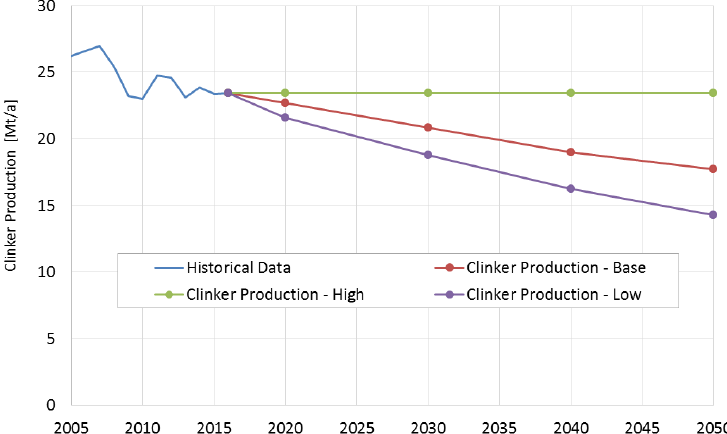
Figure 7. German clinker production projections, base, and low scenarios taken from Fraunhofer ISI